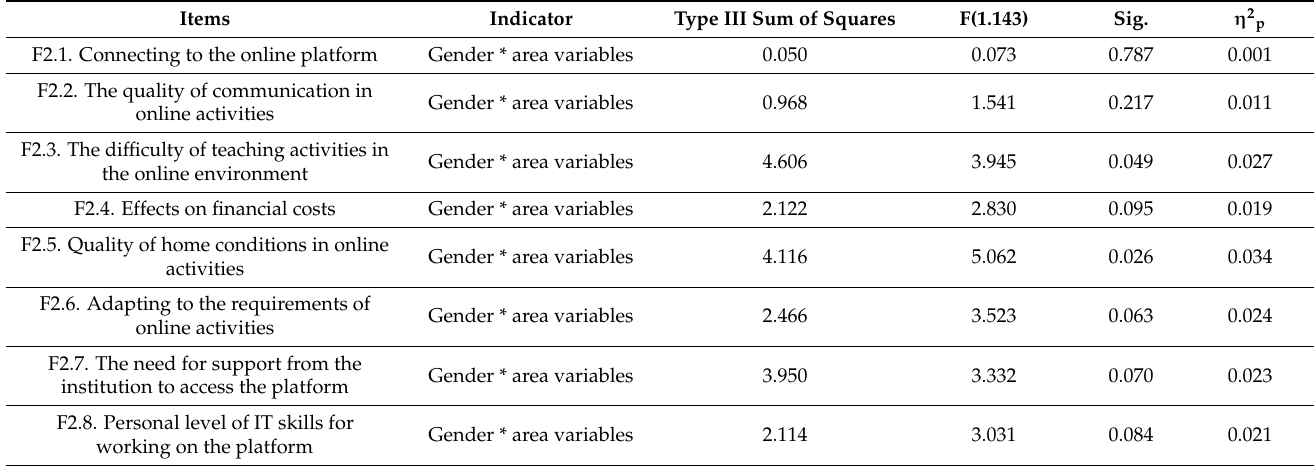
Table 5. Tests of between-subjects’ effects—the cumulative effect of gender variables * area variables on F2 factor items/accessibility.